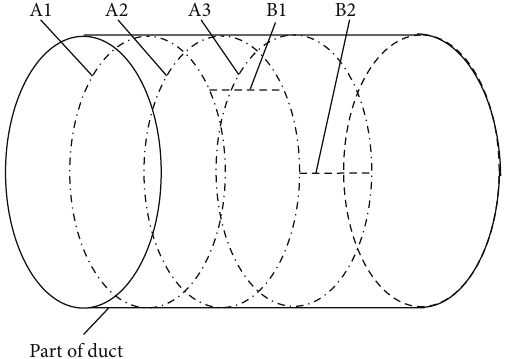
Figure 2: Sketch of sweeping path planned by discontinuous per- ipheral method.